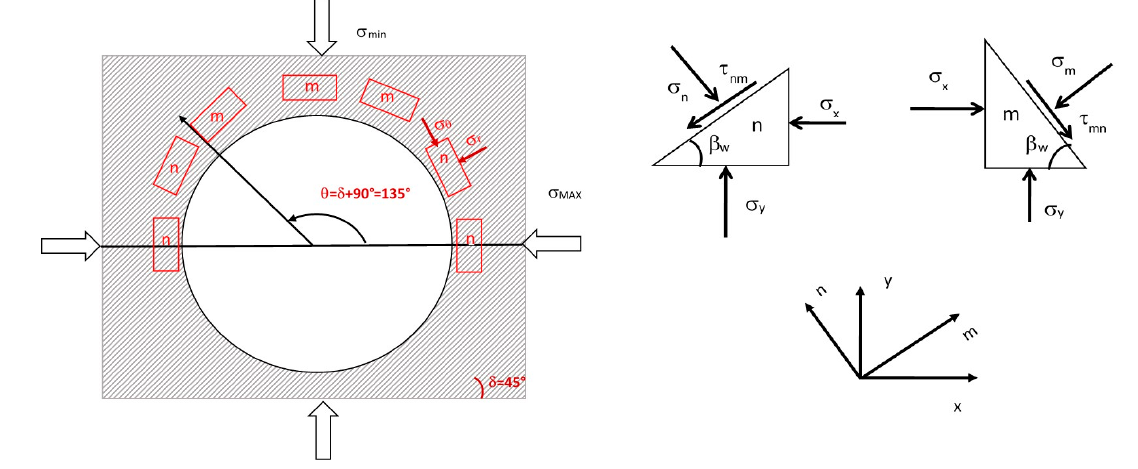
Figure A1. Elements around the wellbore. Definition of the angle β w in the stress transformation law.